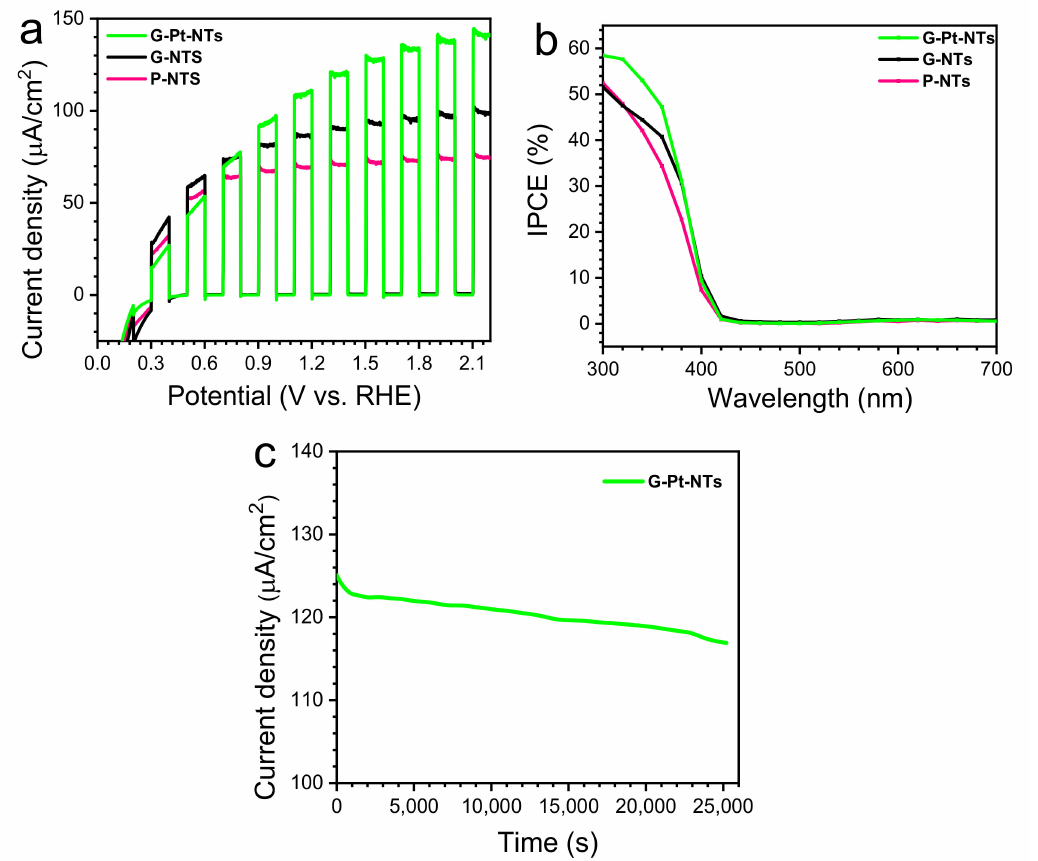
Figure 4. ( a ) Photoelectrochemical response of synthesized samples measured under 1 sun illumination (100 W / m 2 - AM1.5 G) in 1 M NaOH solution, ( b ) corresponding IPCE spectra, ( c ) chronoamperometry test of G-Pt-NTs in 1 M NaOH solution, potential 1.5 V vs RHE for 7 h where the pH is 13.6, E 0 Ag / AgCl = 0.197 V at 298 K, and E 0 Ag / AgCl is the measured potential vs. Ag / AgCl.